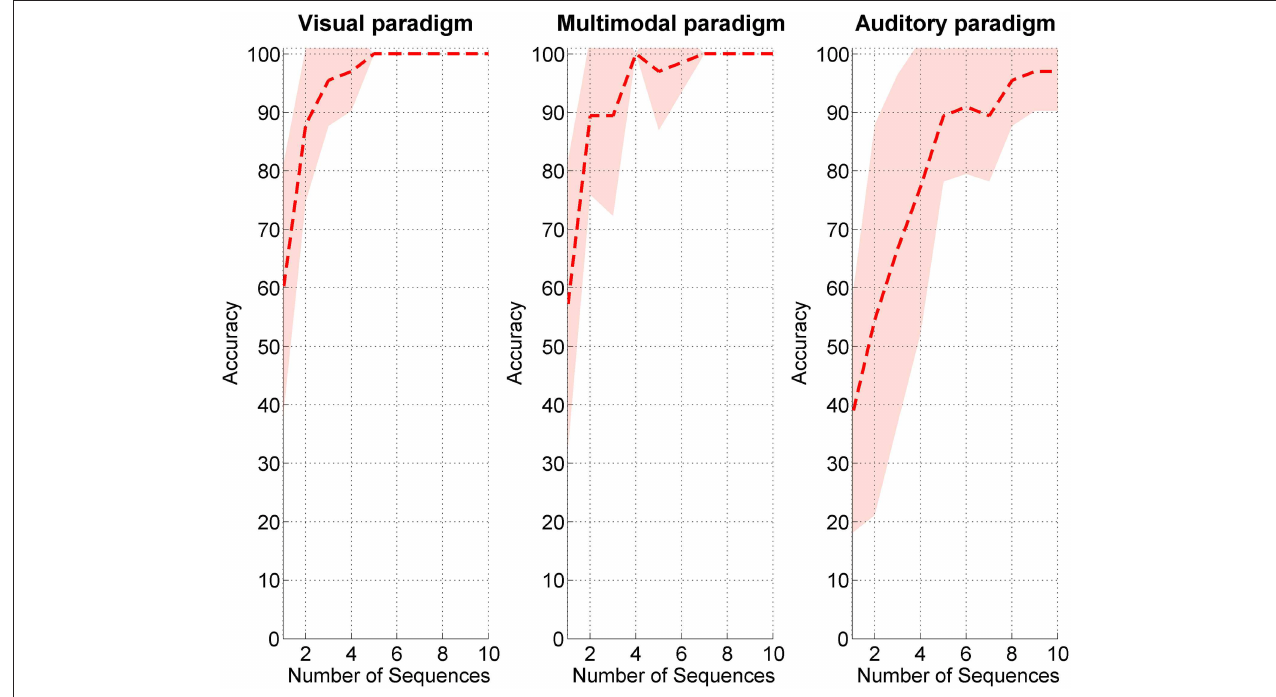
FIGURE 2 | Sequences needed to spell 80% correct in the three spelling paradigms. Standard deviation is depicted in light